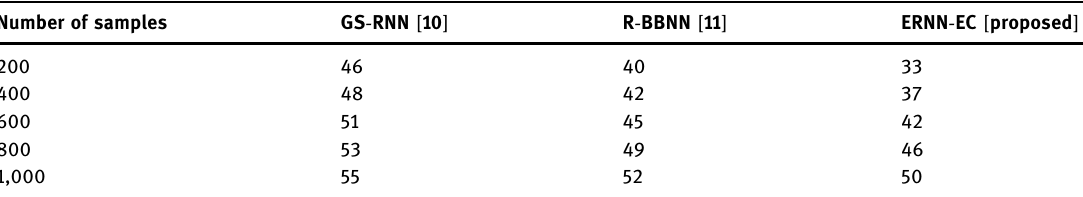
Table 7: Analysis of RAE Number of samples